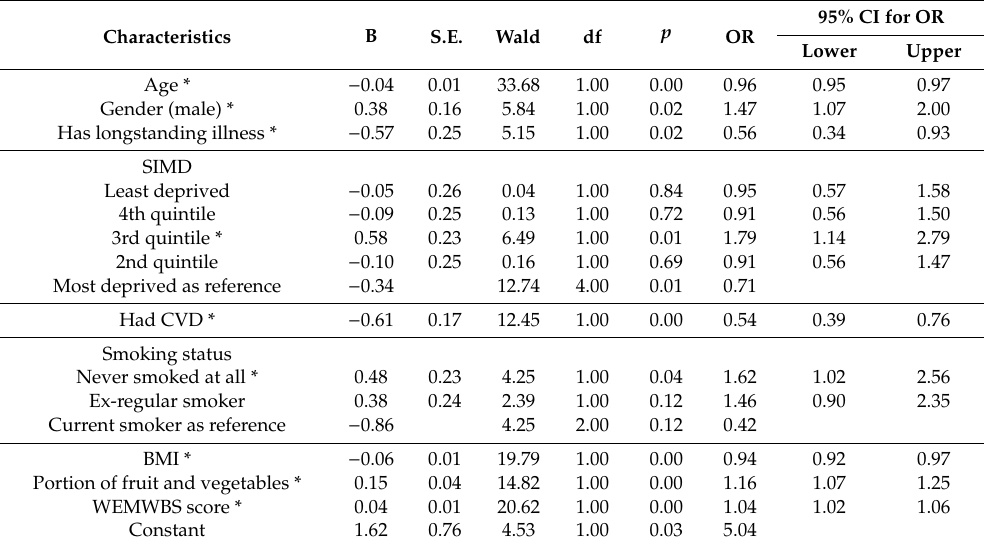
Table 3. Binomial logistic regression predicting the likelihood of meeting recommended physical activity in Scottish adults with